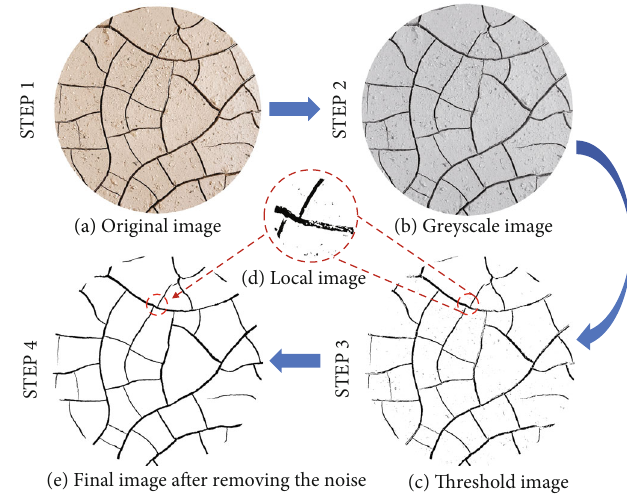
Figure 5: Schematic of crack image